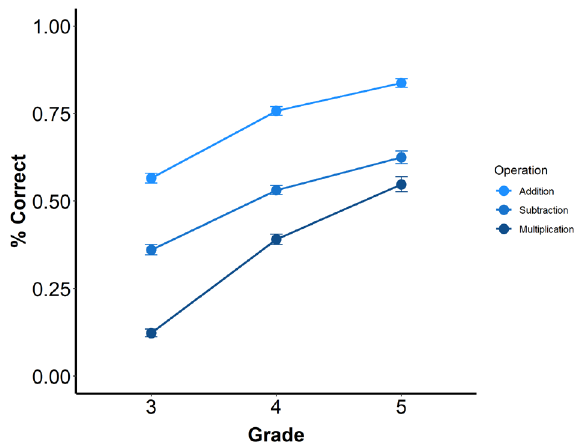
Figure 2. Mean percentage of correct responses for grades and operations. Error bars indicate standard